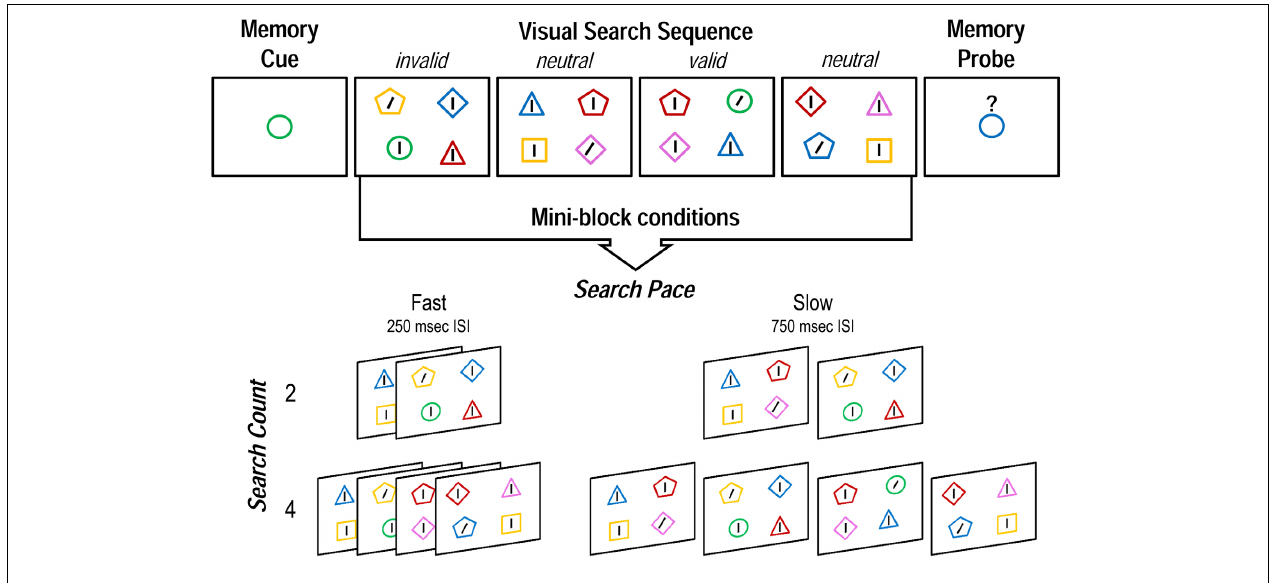
FIGURE 1 | Structure of a single mini-block, and the four possible conditions of the WM delay-spanning visual search sequence in Experiment 1. Invalid, neutral, and valid search displays occurred in random